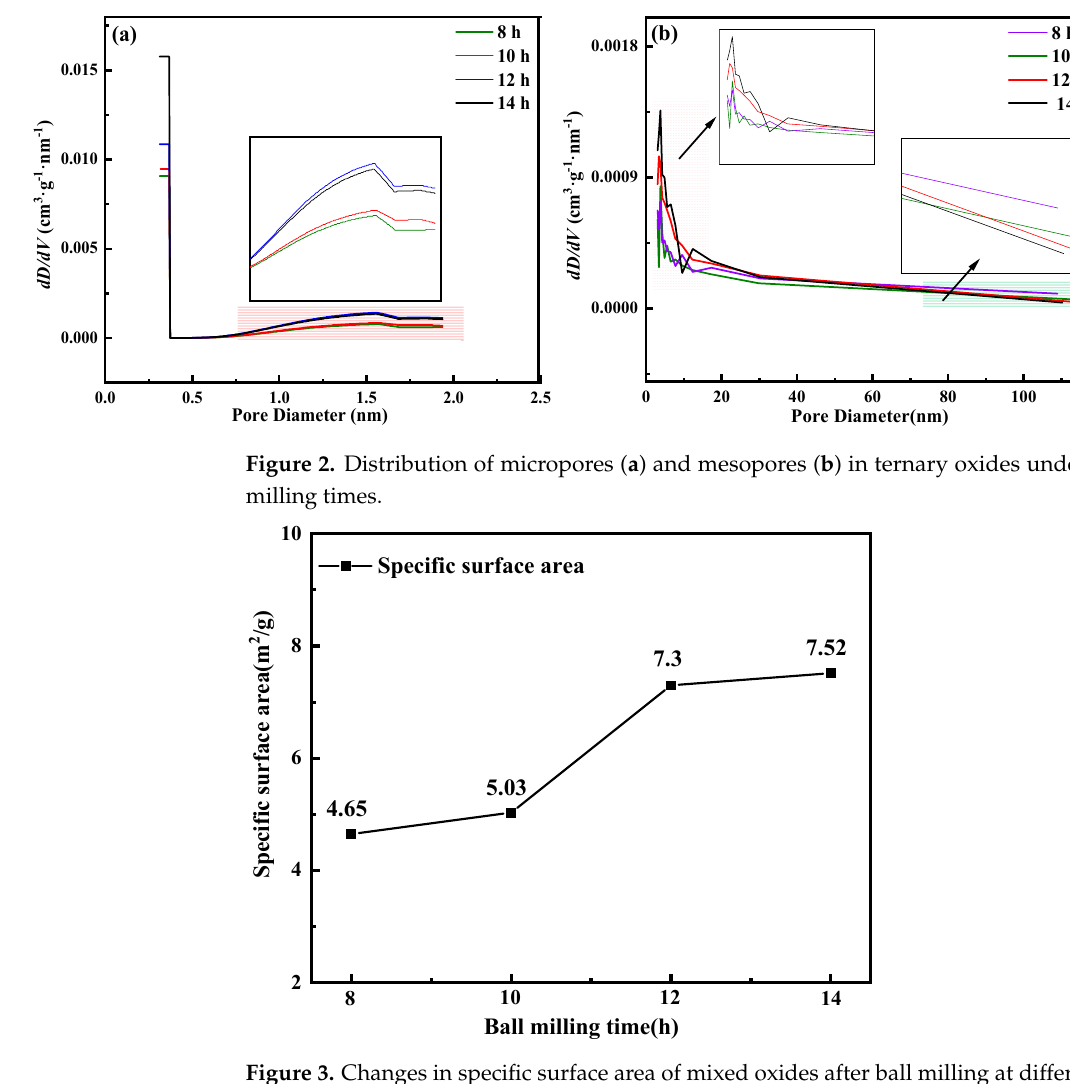
Figure 3. Changes in specific surface area of mixed oxides after ball milling at different times.